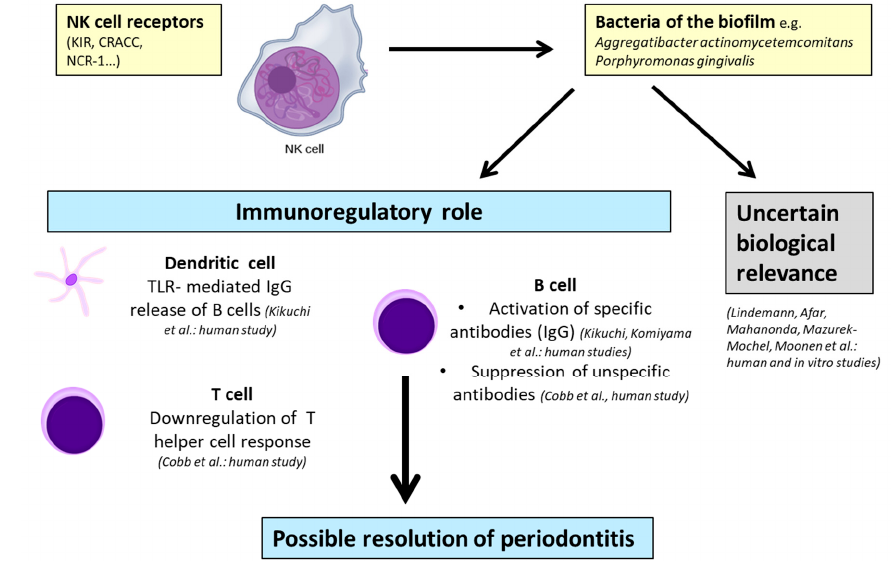
Figure 4. Possible models of immunoregulatory properties and uncertain biological relevance of NK cells in periodontitis: The references and experimental study model are given in parentheses (human, animal, and in vitro). NK cell—natural killer cell; KIR—killer cell immunoglobulin-like receptor; CRACC, CD2-like receptor-activating cytotoxic cell; NCR-1—natural cytotoxicity triggering receptor 1; IgG—immunoglobulin G; and TLR—Toll-like receptor.